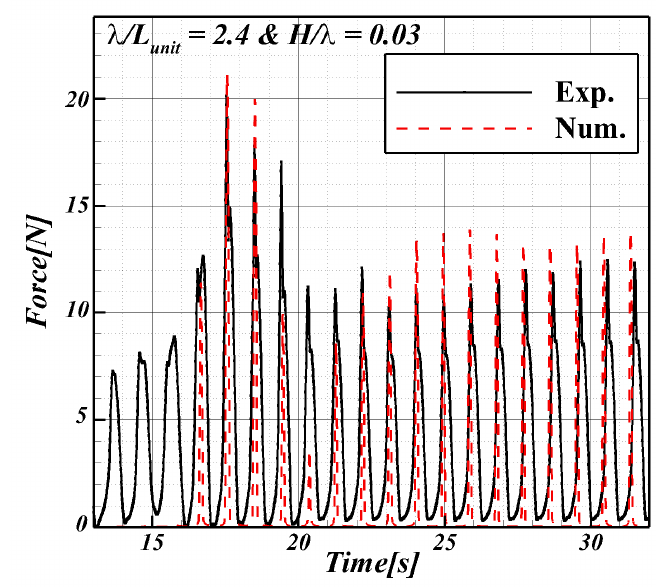
Figure 18. Time series data of total tension at λ / L unit = 2.4 and H / λ = 0.03. Table 6. Comparison of total tension determined by experiment and computation at 𝑯/𝝀 = 0.03. Max. Tension Incident 𝑯/𝝀 𝝀/𝑳 𝒖𝒏𝒊𝒕 [N] (Exp.) Wave Angle